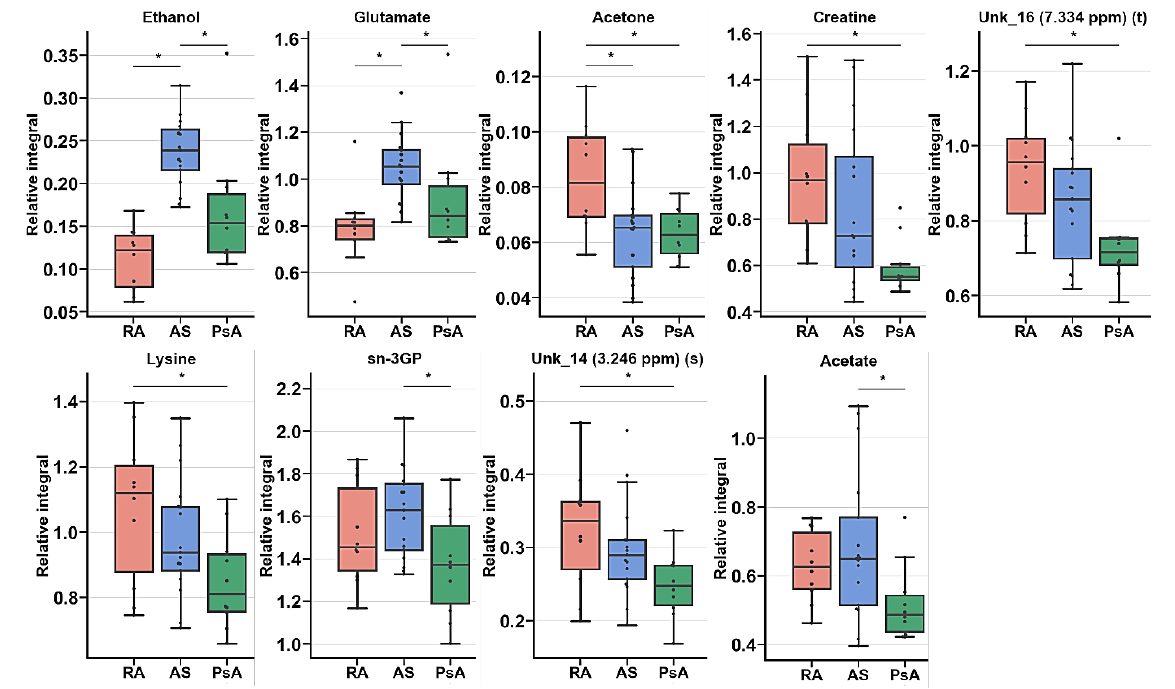
Figure 8. Boxplot for statistically important metabolites for RA, AS, and PsA in ANOVA (In appearance order 2,3,8,12) or Kruskal–Wallis (1,4–7,9–11) test for RA, AS, and PsA groups of patients before treatment. Whiskers—1.5 × interquartile range (IQR); bar—average; box—range between first quartile (Q1) and third quartile (Q3). * Metabolites important in Tukey’s HSD (2,3,8,12) or Dunn– Sidak test (1,4 – 7,9 – 11).